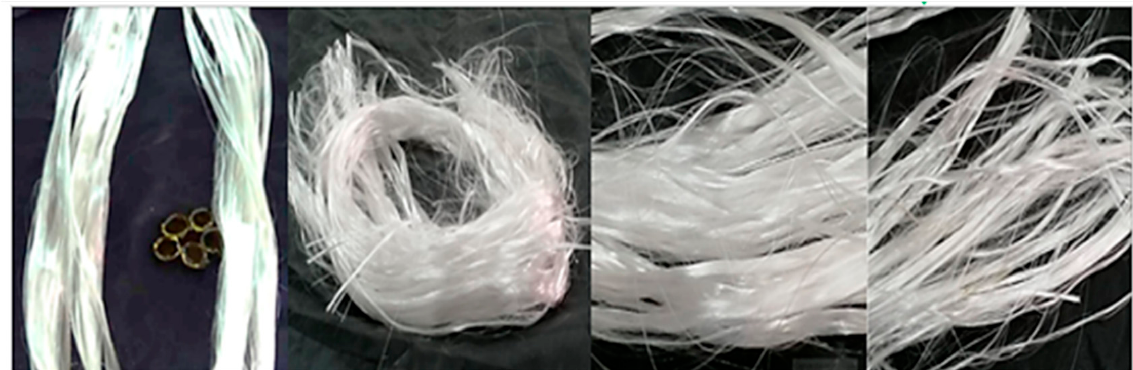
Figure 1. Produced Phosphate glass fibers.